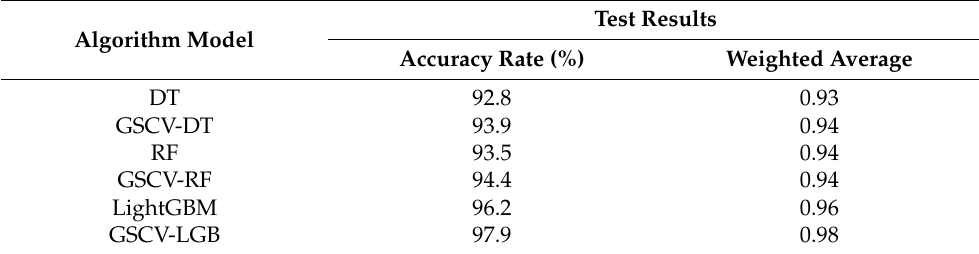
Table 9. Performance test results of each algorithm